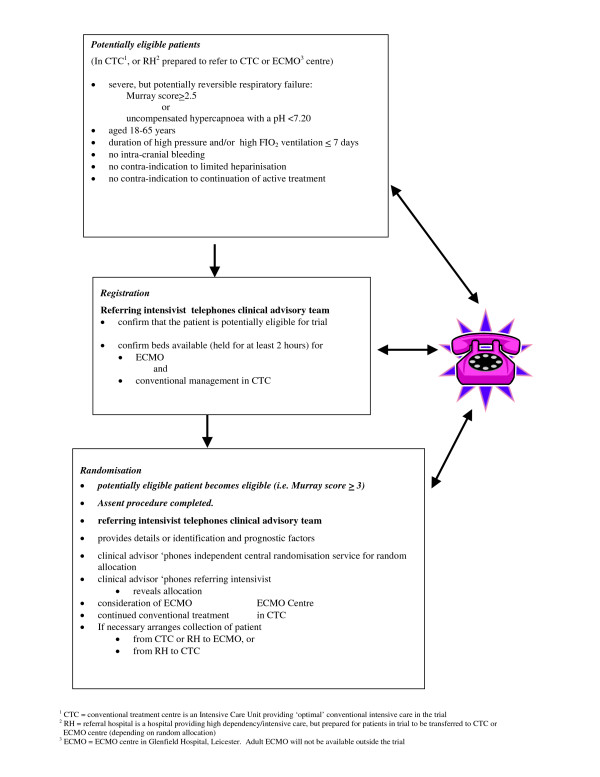
organisation of the trial.